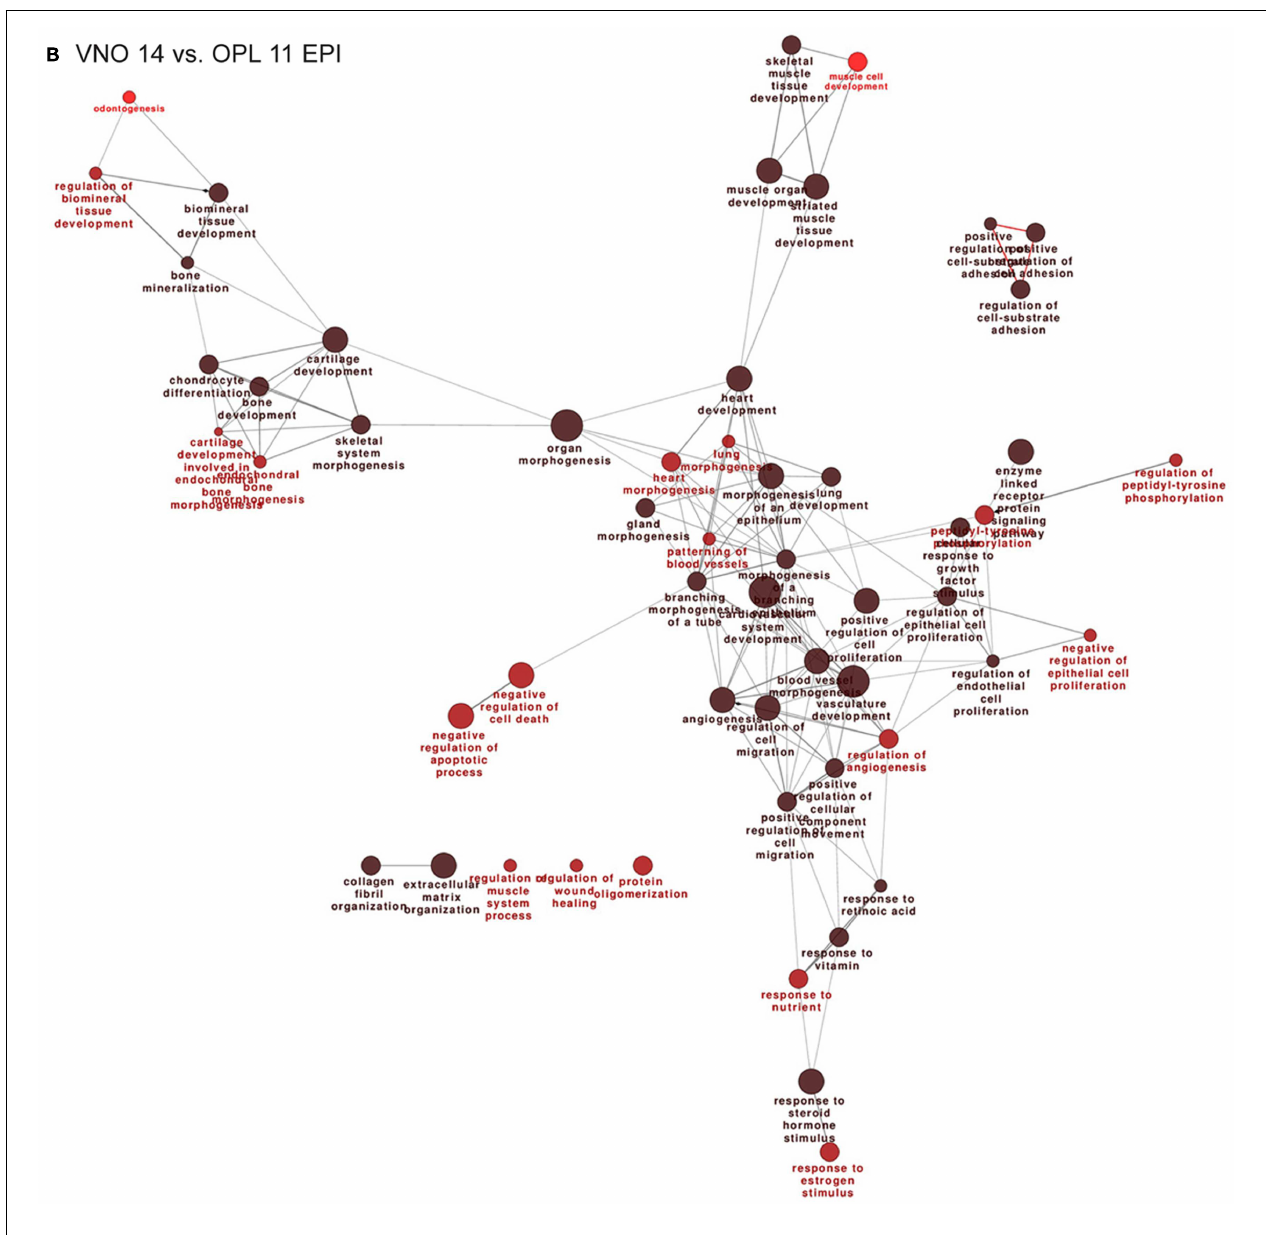
comparing theVNO 14.5 vs. OPL 11.5 (B) were organized them in networks using ClueGO. Only the results of the up-regulated DEGs are shown. Circles represent over-represented categories, lines indicate related